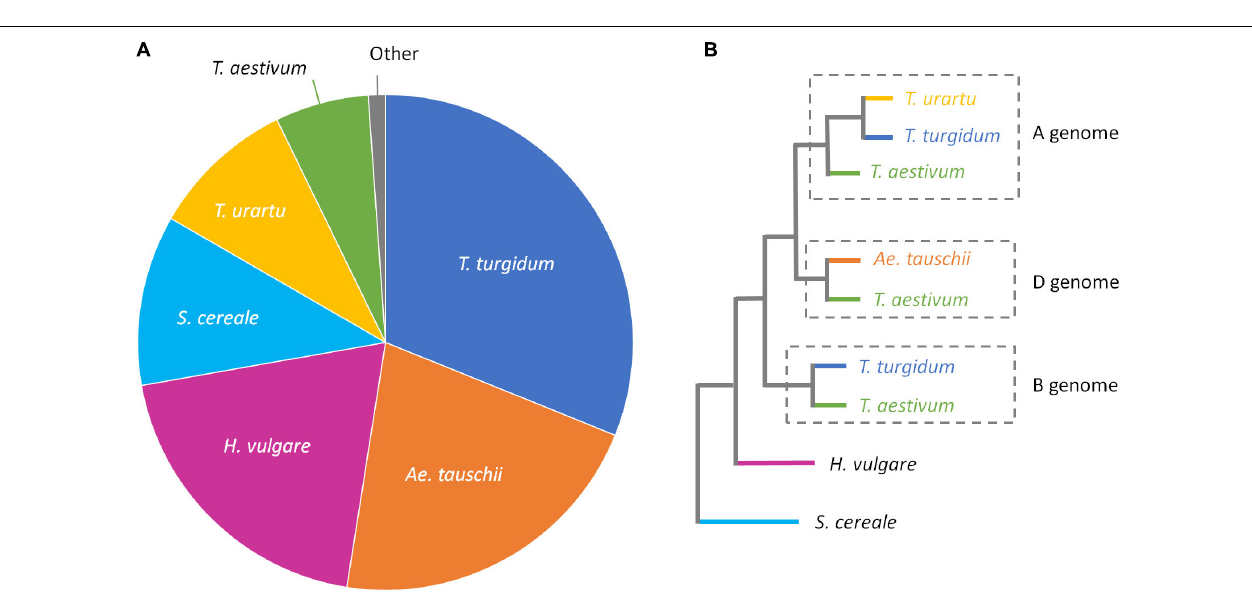
FIGURE 5 | Details of the Pm2 gene in ‘Chinese Spring’ and Ae. tauschii : (A) a 3 bp insertion and (B) a 7 bp insertion. Respectively, green and blue bases are ‘Chinese Spring’ reference sequences before and after the indel. Red bases are the insertion (found in both Ae. tauschii and ‘Maris Huntsman’).